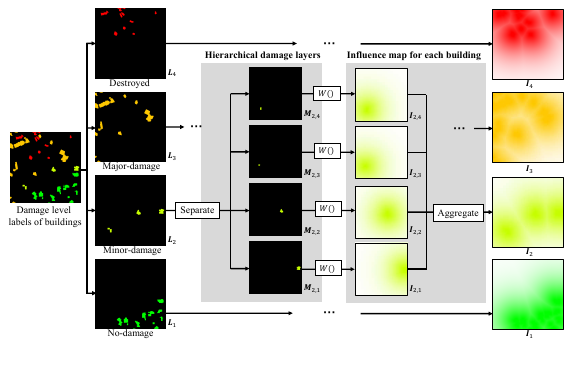
Figure 5. Calculation of influence map. Table 1. Joint damage scale descriptions in the xBD